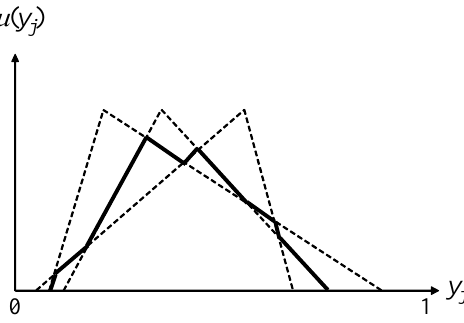
Figure 3. Partial consensus fuzzy intersection.